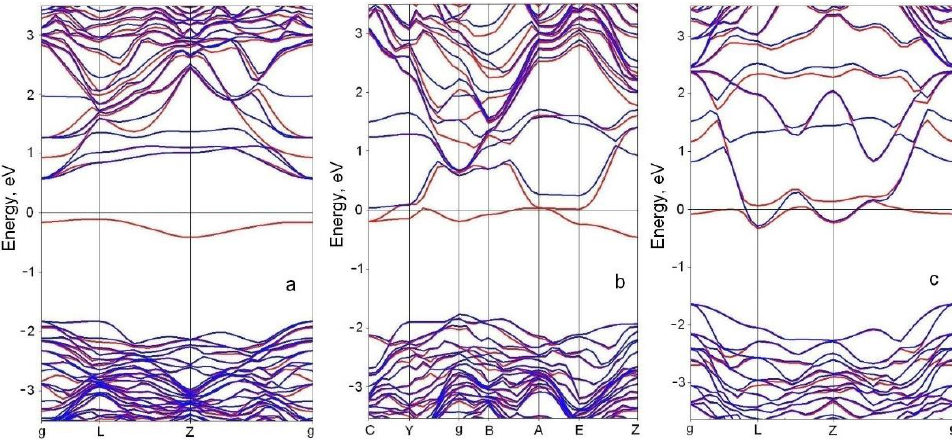
Figure 13. Band structure of three systems with different concentrations n C4V of defects. ( a )—system I, n C = 2.8%; ( b )—system II, n C = 4.2%; ( c )—system III, n C = 6.3%. The red curves correspond to electrons with spin up, the blue curves to those with spin down.